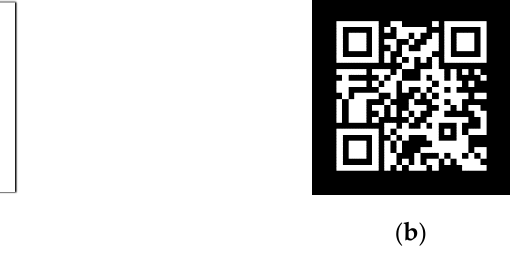
Figure 4. Binary watermark pattern of 150 × 150 size, | W | = 22,500. ( a ) Original watermark W ; with | W 0 | = 7029, | W 1 | = 15,471, ( b ) corresponding watermark complement W of ( a ); with (cid:12)